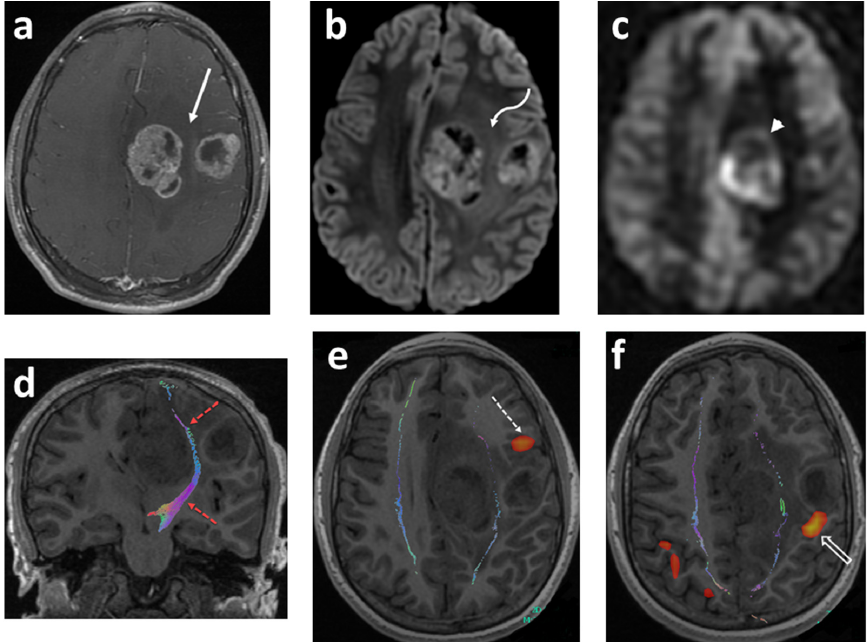
Figure 2. Fourteen-year-old boy with headaches and episodes of right facial and hand numbness. Axial T1 fat sat post contrast ( a ); axial DWI ( b ); axial ASL-PWI ( c ); coronal T1 tractography ( d ); and functional ( e , f ) images. There are two well-defined lobulated heterogeneously enhancing lesions within the posterior aspect of the left frontal lobe (solid white arrow). The lesions show restricted diffusion (curved white arrow) and increased perfusion (arrowhead). The cortical spinal tracts are identified tracking in between the two tumor masses (red–dashed arrows). The Broca’s area is identified in the left inferior frontal gyrus anterior and inferior to the lateral frontal mass lesion (dashed arrow). The motor cortex with right finger tapping is immediately posterior to the smaller mass in the lateral aspect of the left frontal lobe (open arrow). Pathology: giant cell glioblastoma (author’s institutional human ethics committee/institutional review board guidelines were followed for anonymized images) .